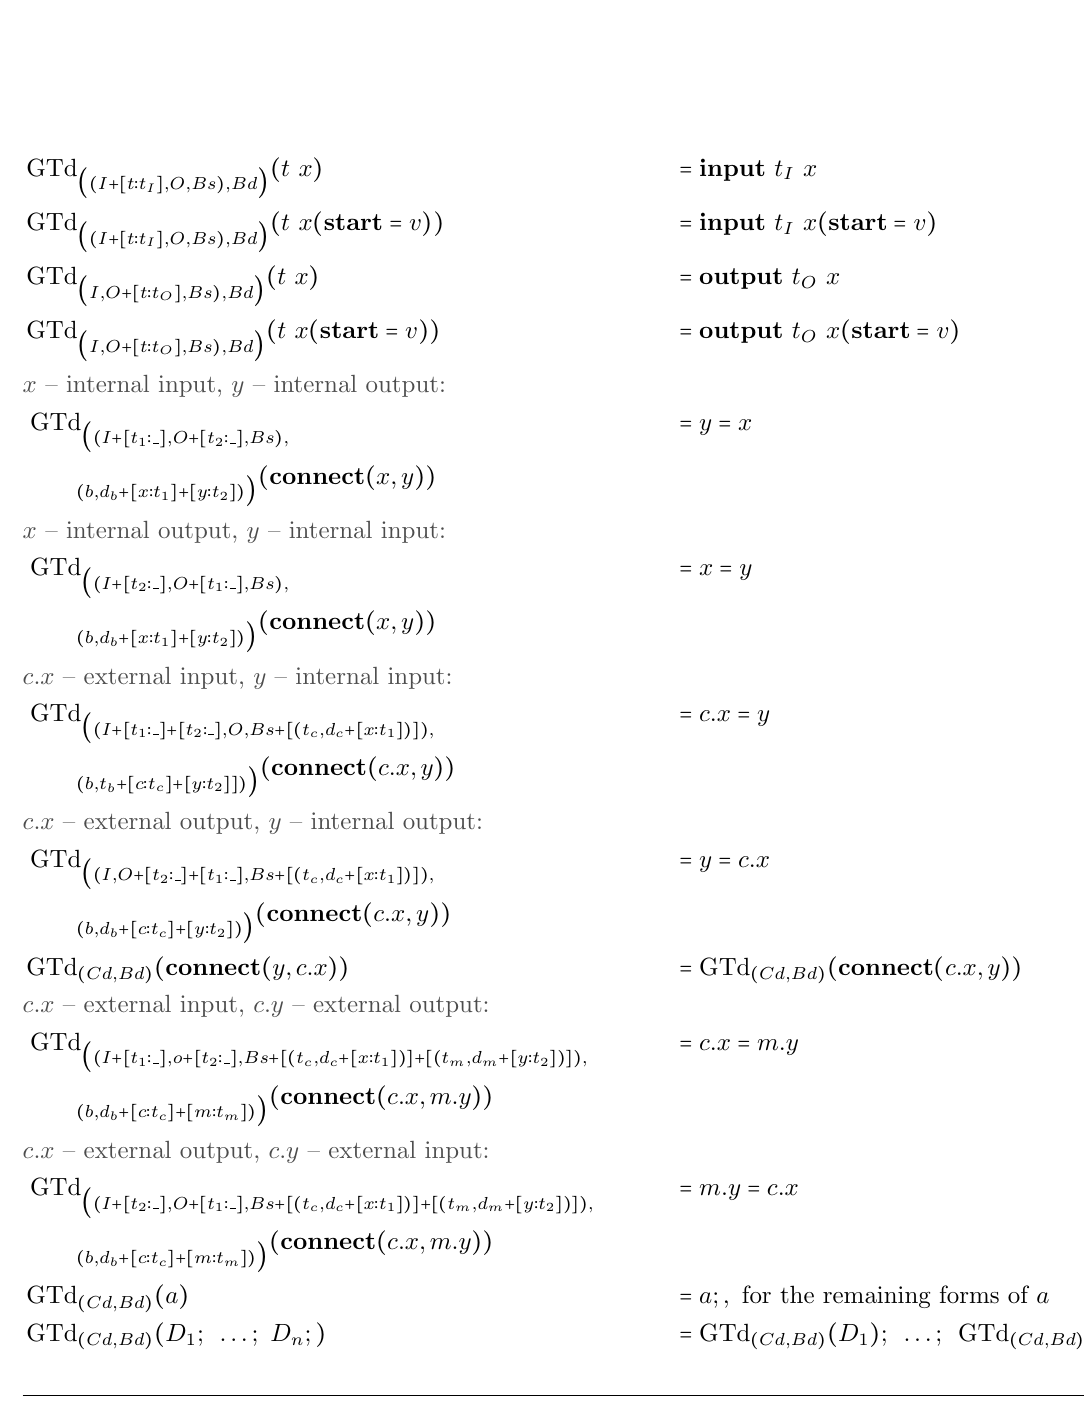
Figure 15: Function GTd—Replace connect -equations by equations of the form “ x = e